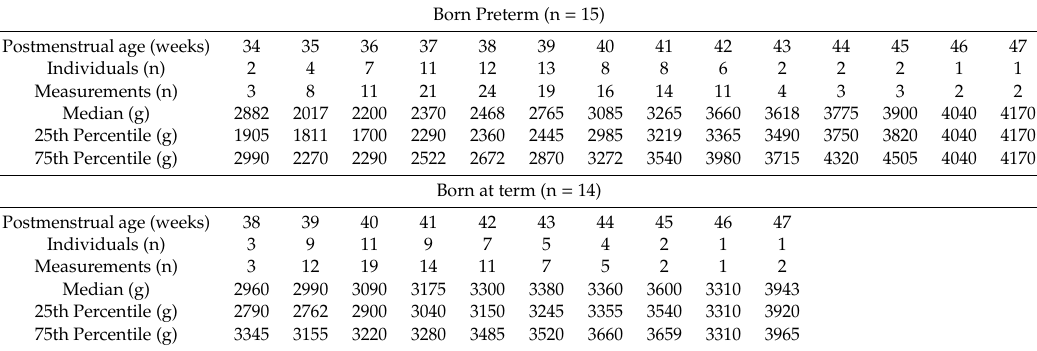
Table 8. Evolution of body weight in infants born preterm and at term. Born Preterm (n = 15)